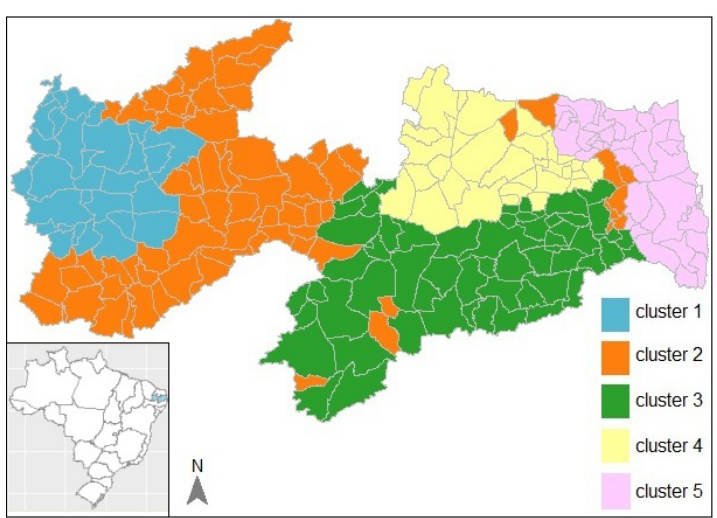
Figure 4. Map of the partition with K = 5 clusters based on the socio-epidemiological distances D 0 and the geographical distances between the municipalities D 1 with α = 0.17.